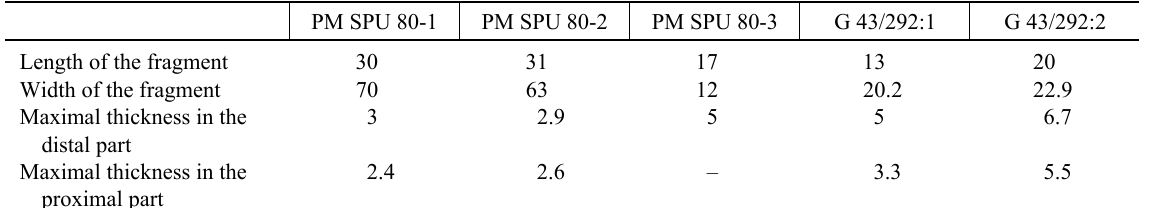
Table 1. Measurements of fragments of branchial plates (in